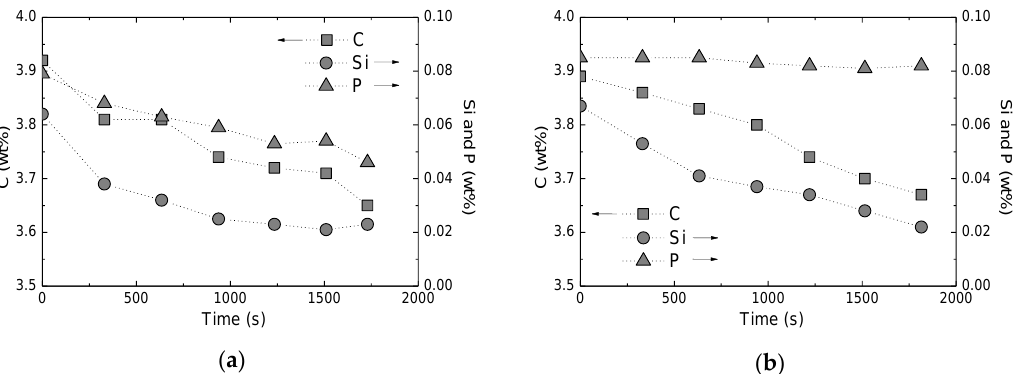
Figure 6. Changes in C, Si and P contents of hot metals subjected to different oxygen supply methods: ( a ) iron ore top charging; ( b ) dehydrated air injection.